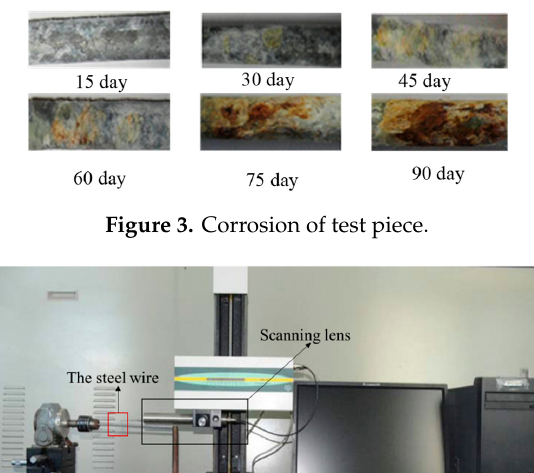
Figure 3. Corrosion of test piece.